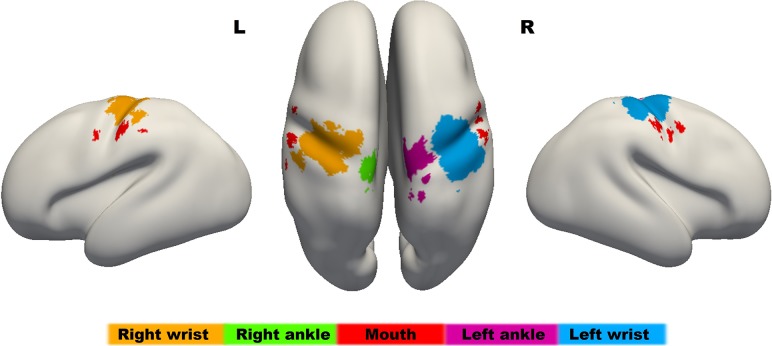
The sensorimotor homunculus in the preterm human brain at 34 weeks PMA. The map has been overlaid onto an age-specific inflated brain template using a “winner-takes-all” approach after combing the significant results of the group level activation maps from each stimulated body part. In agreement with the well characterized adult somatotopic map, functional activity relating to the ankles (green and purple) is located superiorly to those of the wrist (orange and blue) and mouth (red). This map will be made publically available for download from brain-development.org.